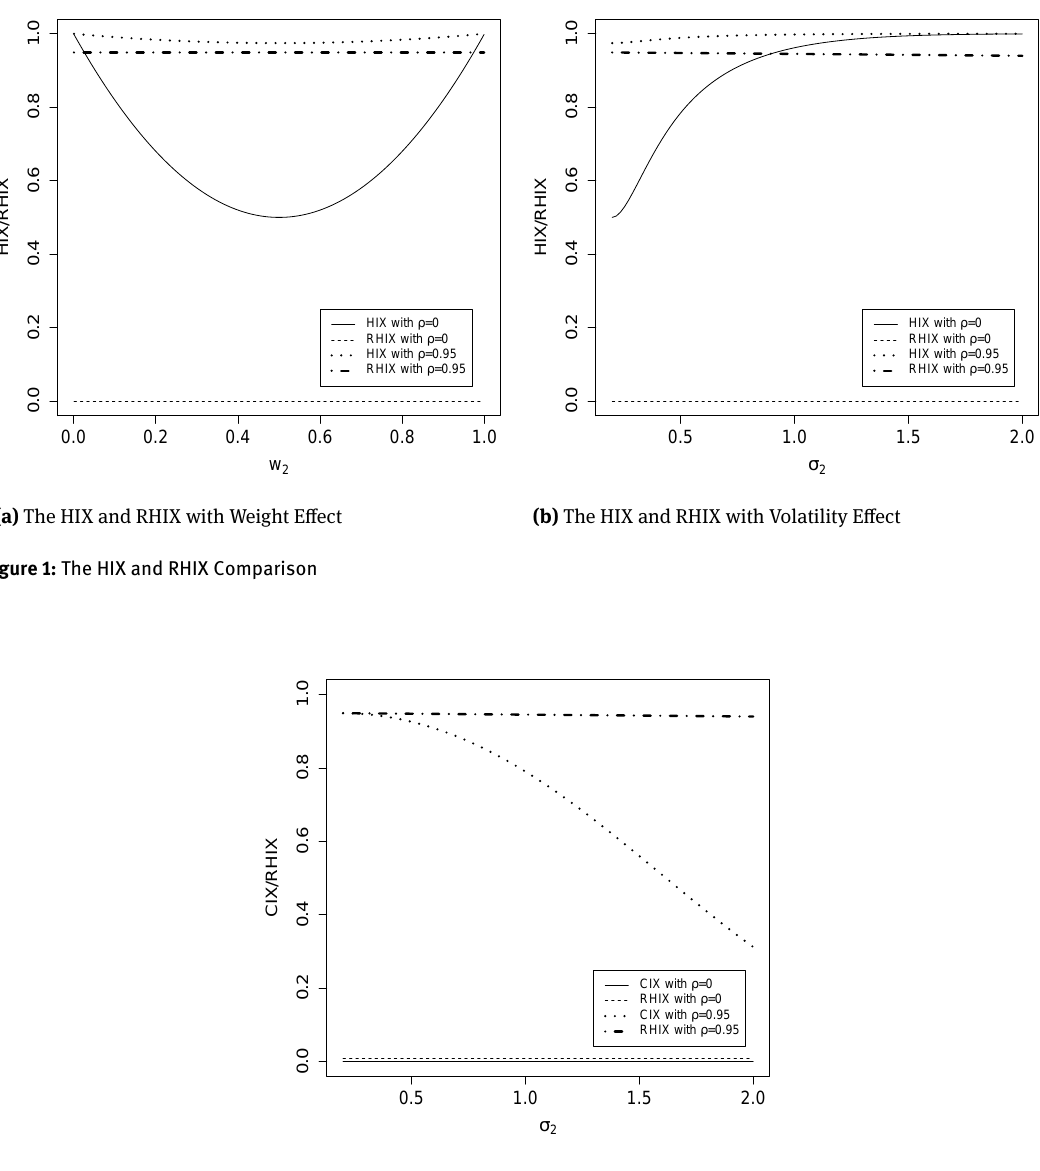
Figure 2: The CIX and RHIX Comparison by Volatility Effect